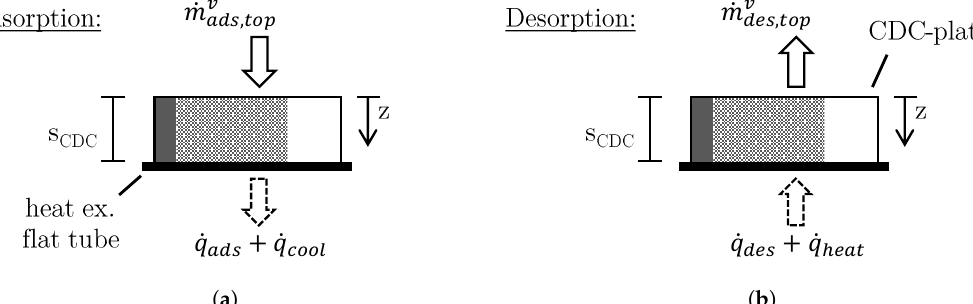
Figure 4. CDC plate on heat exchange flat tube with mass and energy flow densities during adsorption ( a ) and desorption ( b